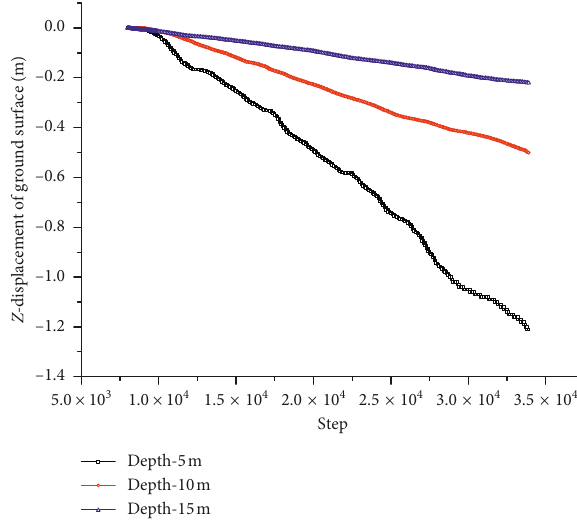
Figure 21: The subsidence curve of surface soil under different